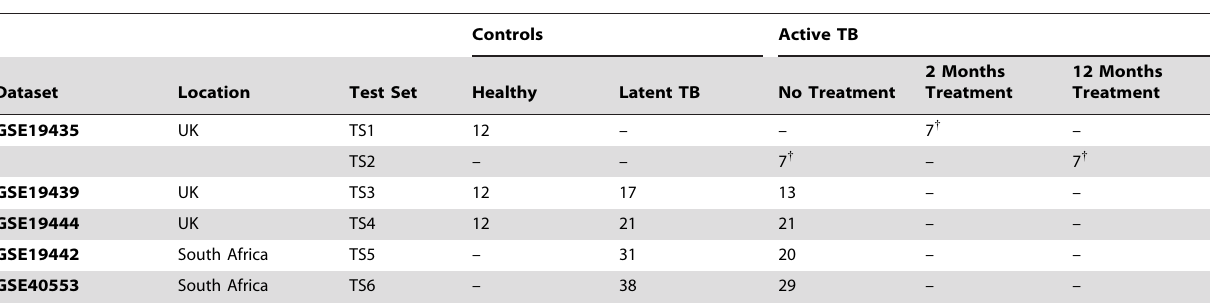
Table 2. Test Set